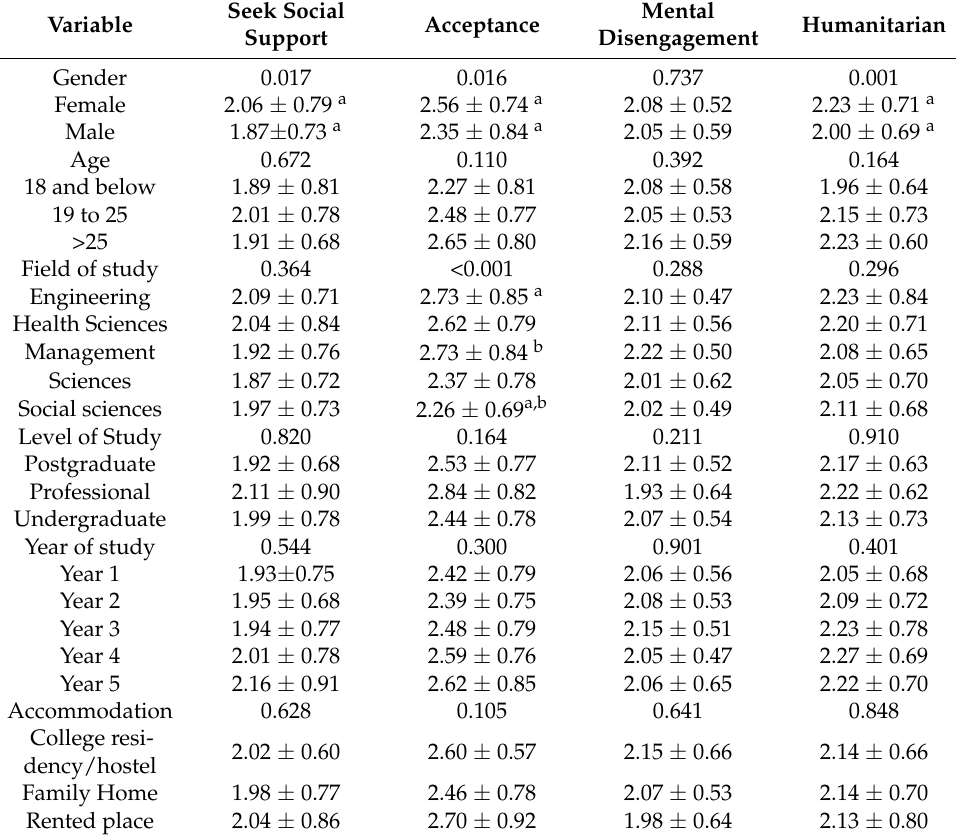
Table 5. Results from Multivariate analysis of variance